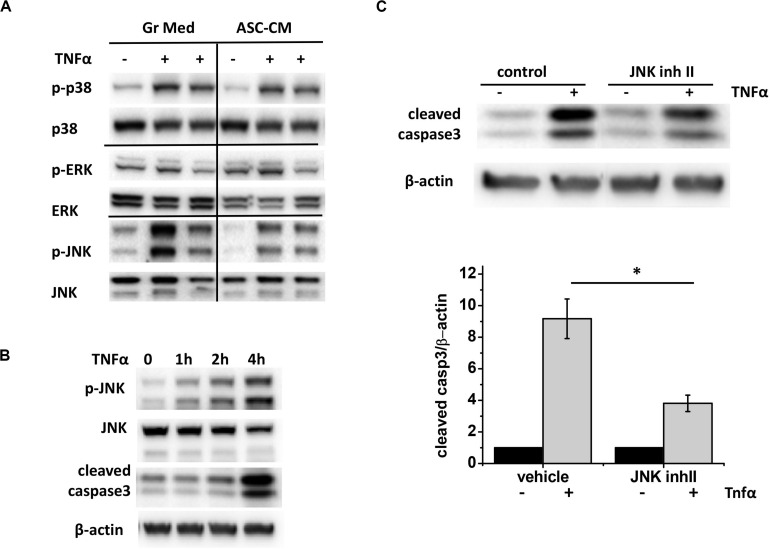
ASC-CM exposure suppresses JNK activation, which precedes and contributes to caspase activation in response to TNFα in the endothelium. (A) HPAEC exposed to growth media or ASC-CM were challenged with 2 ng/ml TNFα for 4 h. Cell lysates were analyzed with antibodies to phospho- and pan-p38, phospho- and pan-ERK, and phospho- and pan-JNK. (B) HPAEC were stimulated with 2 ng/ml TNFα for the times indicated. Cell lysates were analyzed with antibodies to p-JNK, JNK, cleaved caspase 3, and β-actin (loading control). (C) HPAEC pretreated with vehicle control or 5 μM JNK inhibitor II for 30 min were treated with 2 ng/ml TNFα for 4 h. Data from three independent experiments were pooled and presented as cleaved caspase 3/β-actin ratio, normalized to no TNF control. ∗t-test with Welch’s correction was used to detect significant differences (p < 0.05).